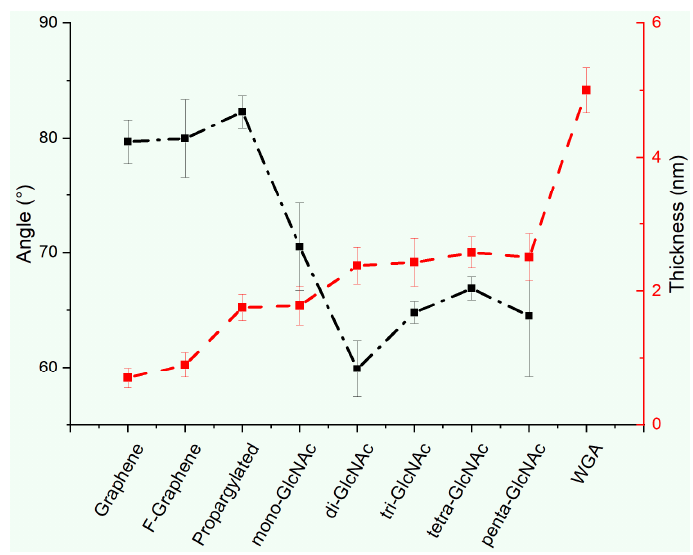
Figure 2. Summary of the AFM and CA data for graphene functionalization. AFM shows a gradual increase in the layer thickness with increasing size of the grafted species. Longer chitooligomers tended to fold back; hence, the thickness reached a plateau for tri- to penta-GlcNAc species. Importantly, after incubation with WGA, all chitooligomers showed a constant thickness of about 5 nm. Correspondingly, the CA decreased when hydrophilic carbohydrates were grafted onto the graphene surface, and a plateau of between 60° and 65° was reached for tri-GlcNAc and longer chitooligomers. See the Supplementary Materials for definitions of error bars.